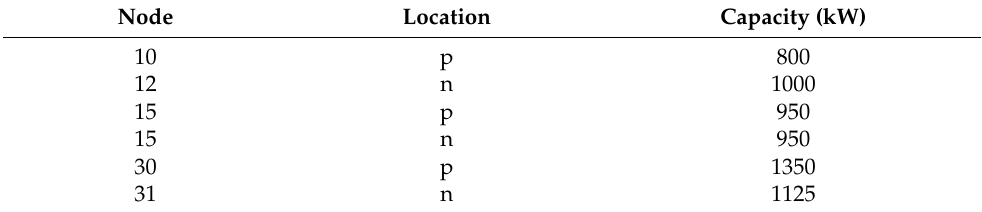
Table 4. Location and Capacity of the dispersed sources for the 33-bus